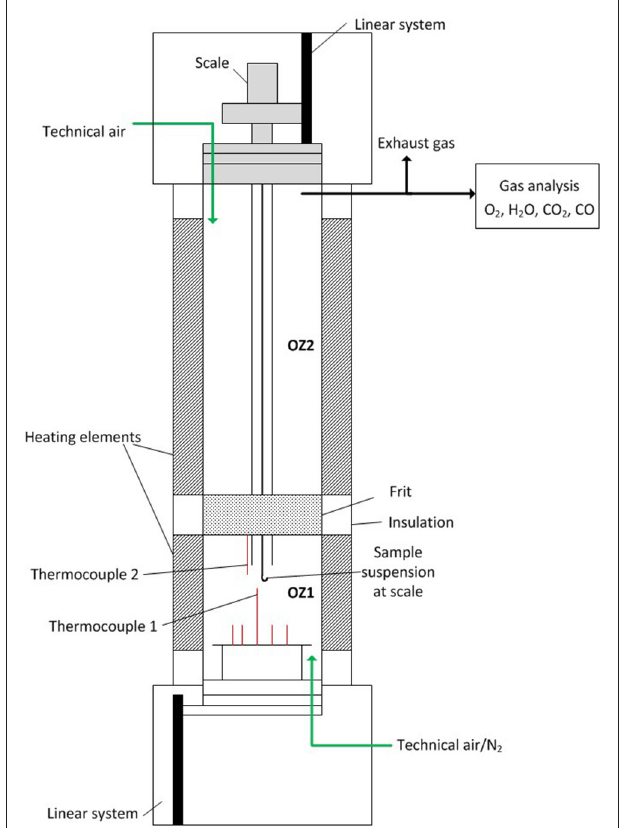
FIGURE 1 | Used flat die press 14-175 by Amandus Kahl.